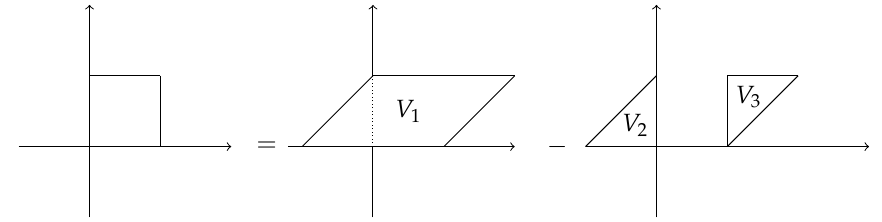
Figure 2. Domains for calculating (cid:101) A n , m